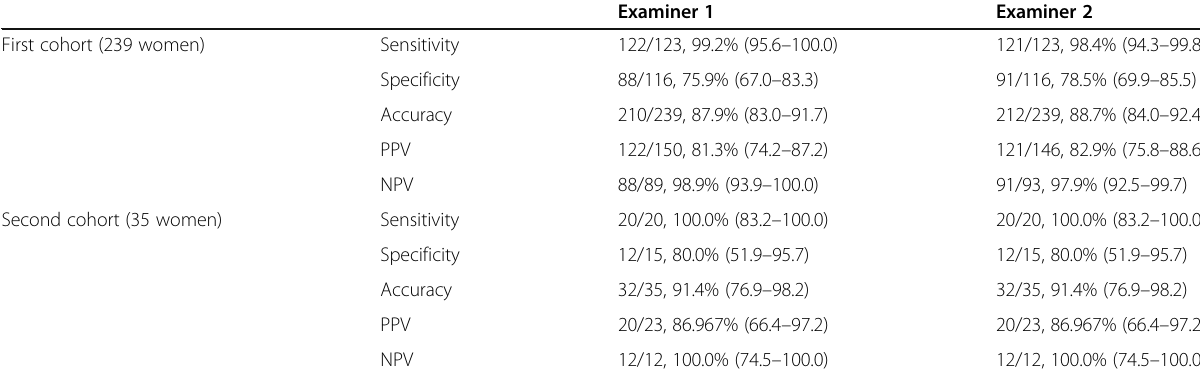
Table 4 Performances of the decision support system for the two patient cohorts and the two